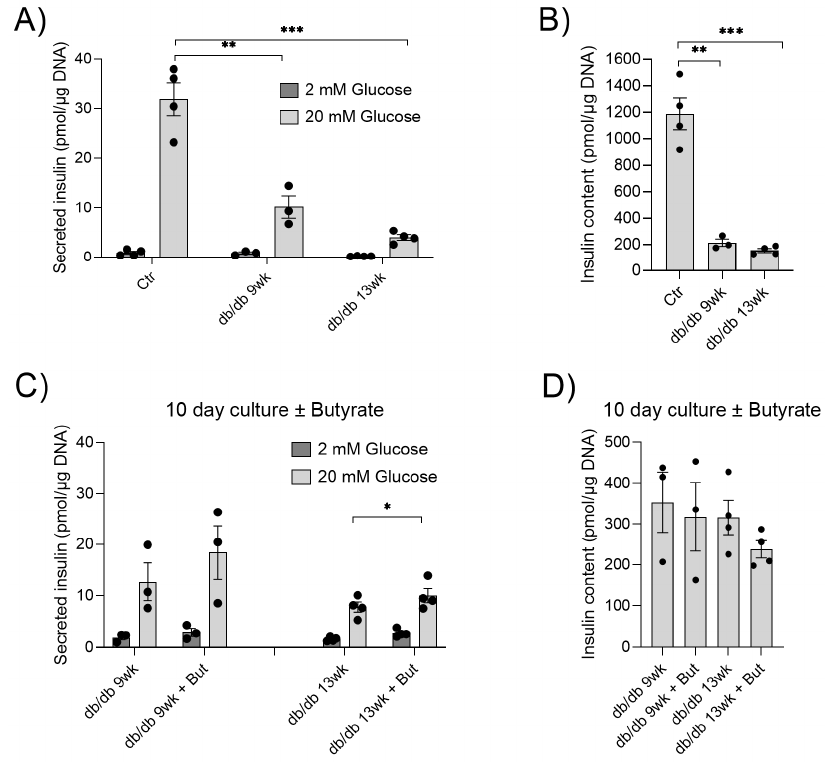
Figure 1. In vitro effects of butyrate on glucose-stimulated insulin secretion and insulin content in islets. ( A ) Insulin secretion from islets isolated from control C57BL/6 mice (Ctr), or db/db mice, at 9 weeks (9 wk) or 13 weeks (13 wk) of age, was measured by static batch incubations in response to 2 mM and 20 mM glucose, and normalized to DNA. ( B ) Insulin content measured post-assay. ( C ) Insulin secretion from db/db islets cultured with and without 0.2 mM butyrate (But) for 10 days. ( D ) Insulin content measured post-assay. Bars show the mean ± SEM. * p < 0.05, ** p < 0.01 and *** p < 0.001.